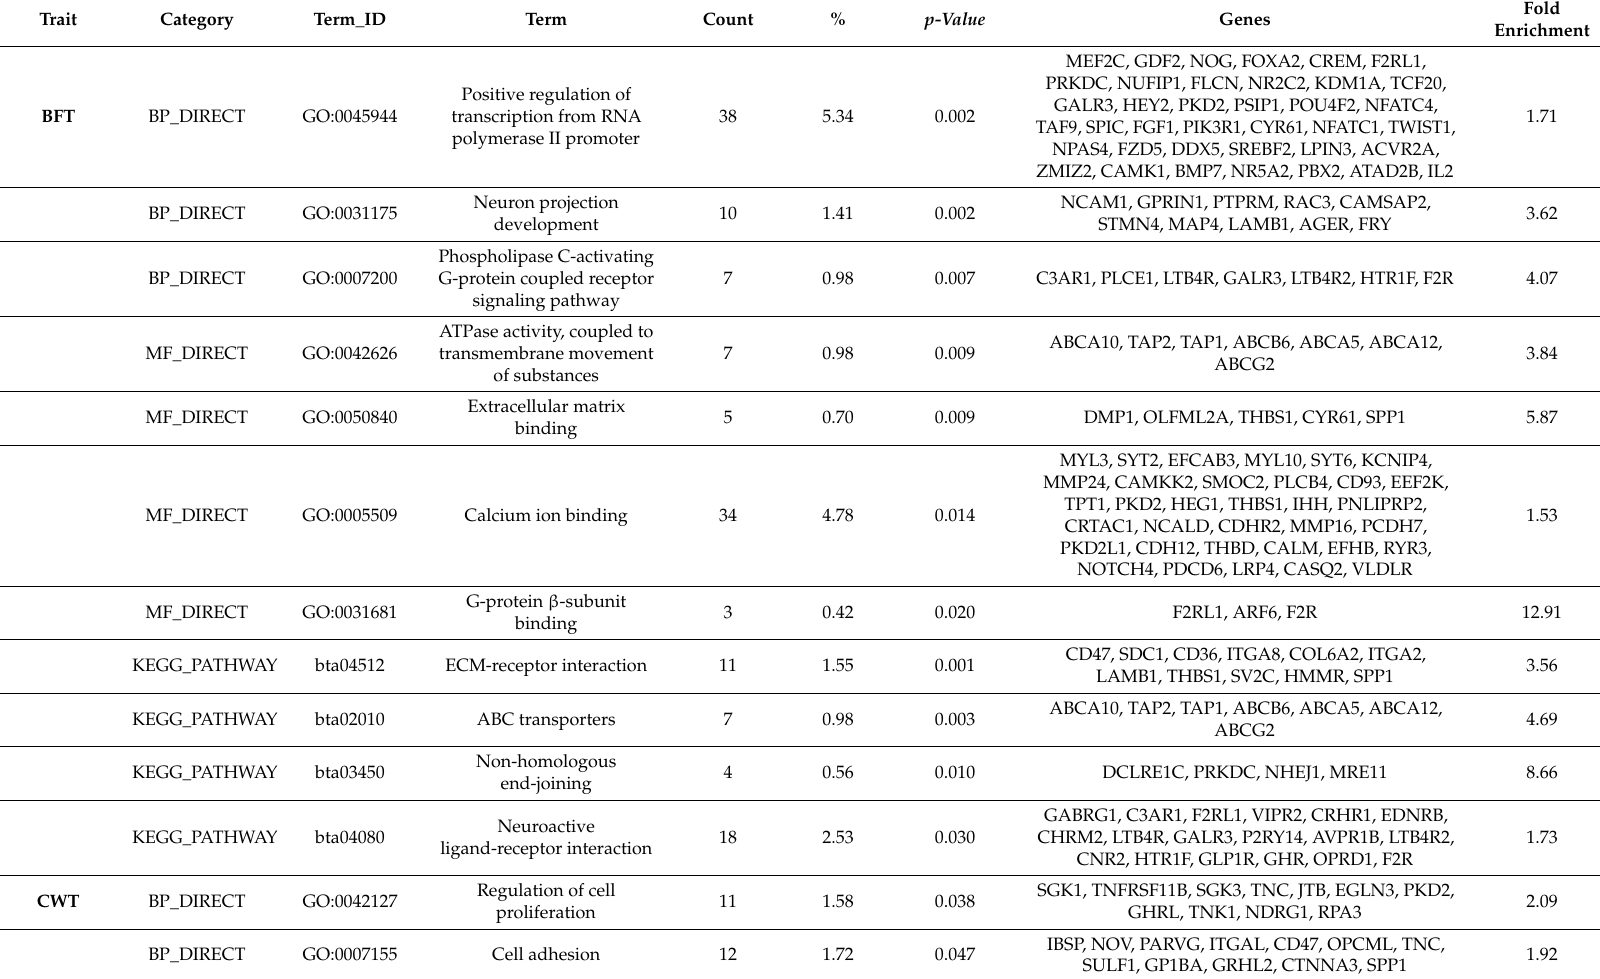
Table 5. Gene Ontology (GO) terms and KEGG pathways significantly enriched using genes associated with